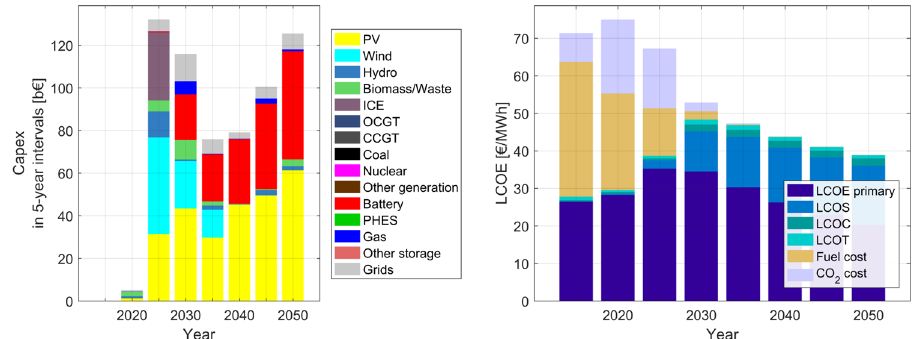
Fig. 7 | Capital expenditures for 5-year intervals (a) and levelised cost of elec- tricity (b) during the energy transition from 2015 to 2050 across India. The highestinvestmentstakeplacein2025,whenthesystemneedstoinvestthemostin building a new renewable energy based power system, as fossil fuels based